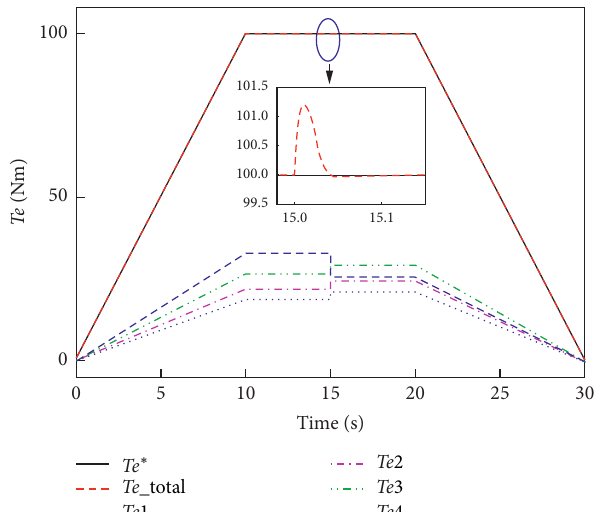
Figure 5: The changing curve of the total traction torque and each motor traction torque output when the fourth motor loses 30% traction